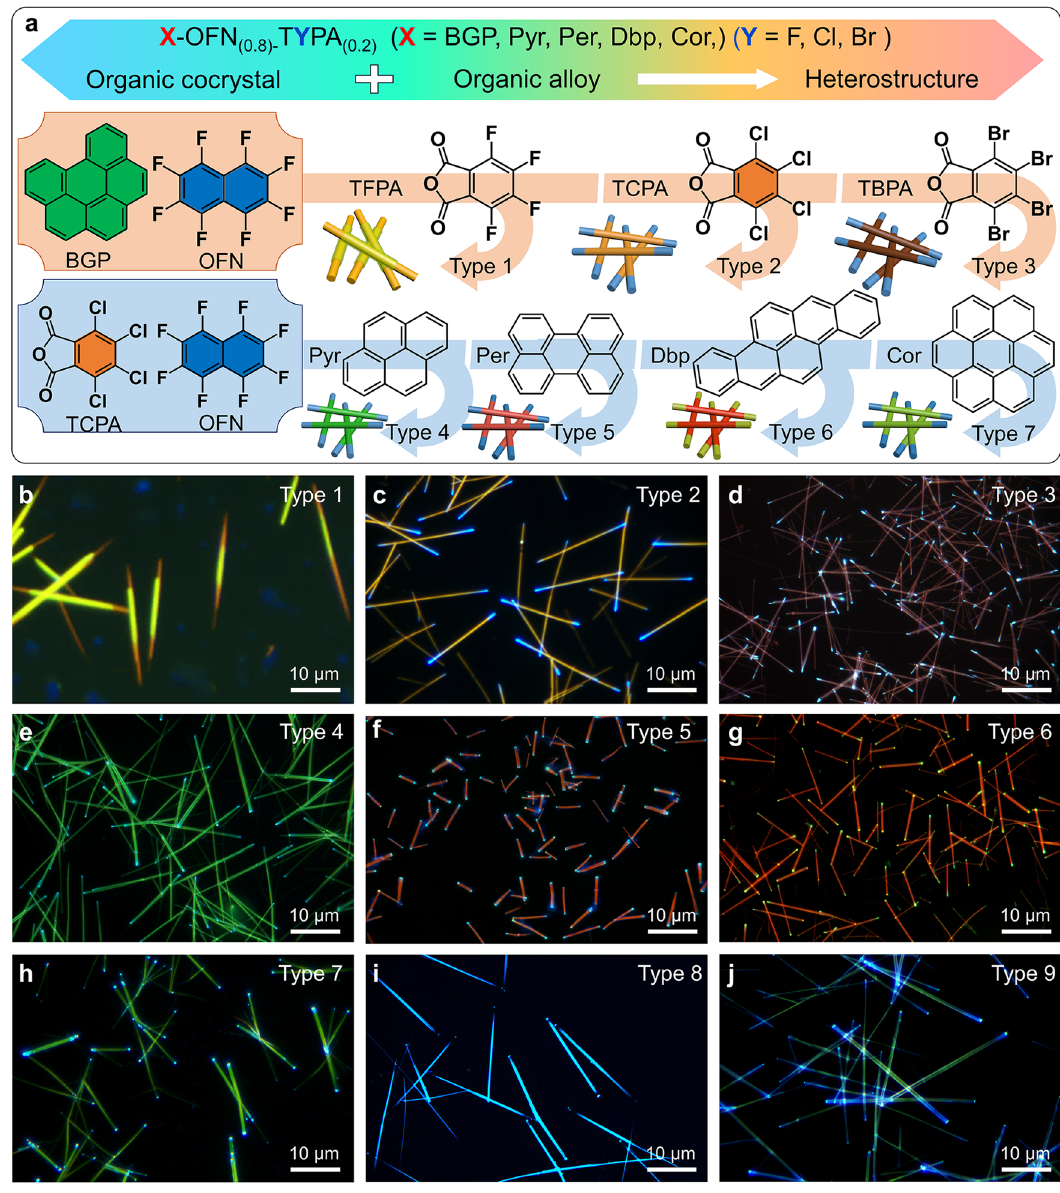
Fig. 6 Synthesis of nine types of triblock nanowires. a Scheme for the synthesis of the nine types of triblock nanowires composed of organic X-TYPA (X = BGP, Pyr, Per, Dbp, Cor, Trp, Dba) (Y = F, Cl, Br) cocrystals and the corresponding X-OFN (0.8) -TYPA (0.2) alloys. b – j FM images of heterostructure nanowires under UV excitation. All scale bar is 10 μ